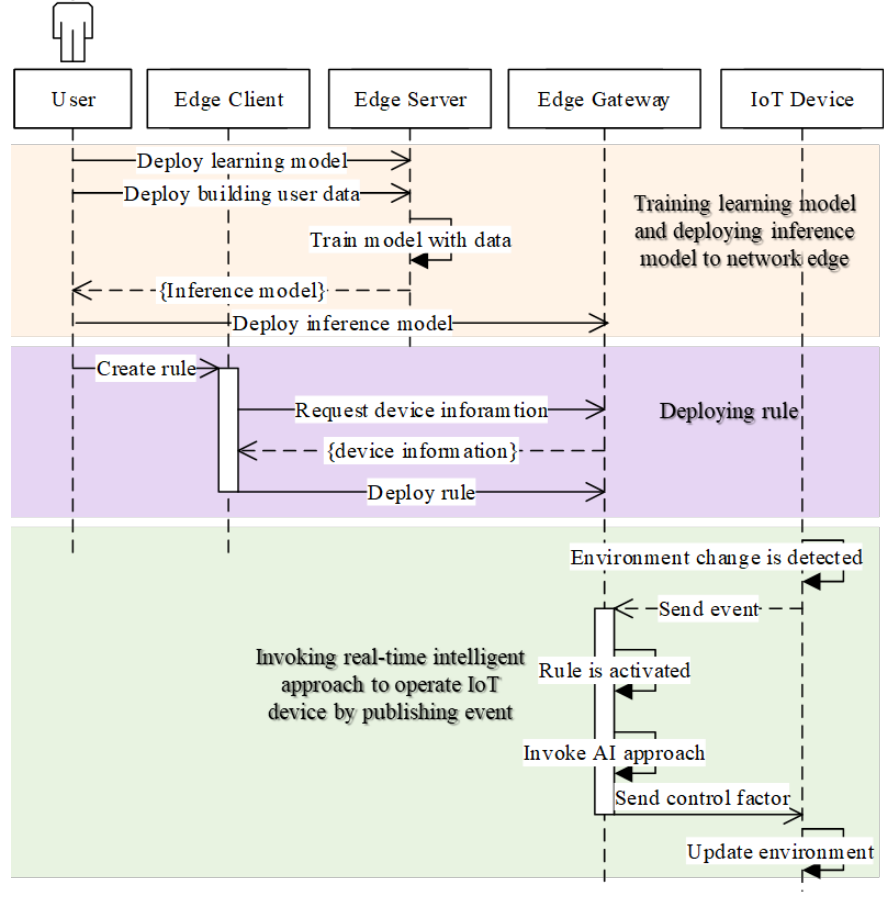
Figure 6. Intelligent IoT device operation sequence.